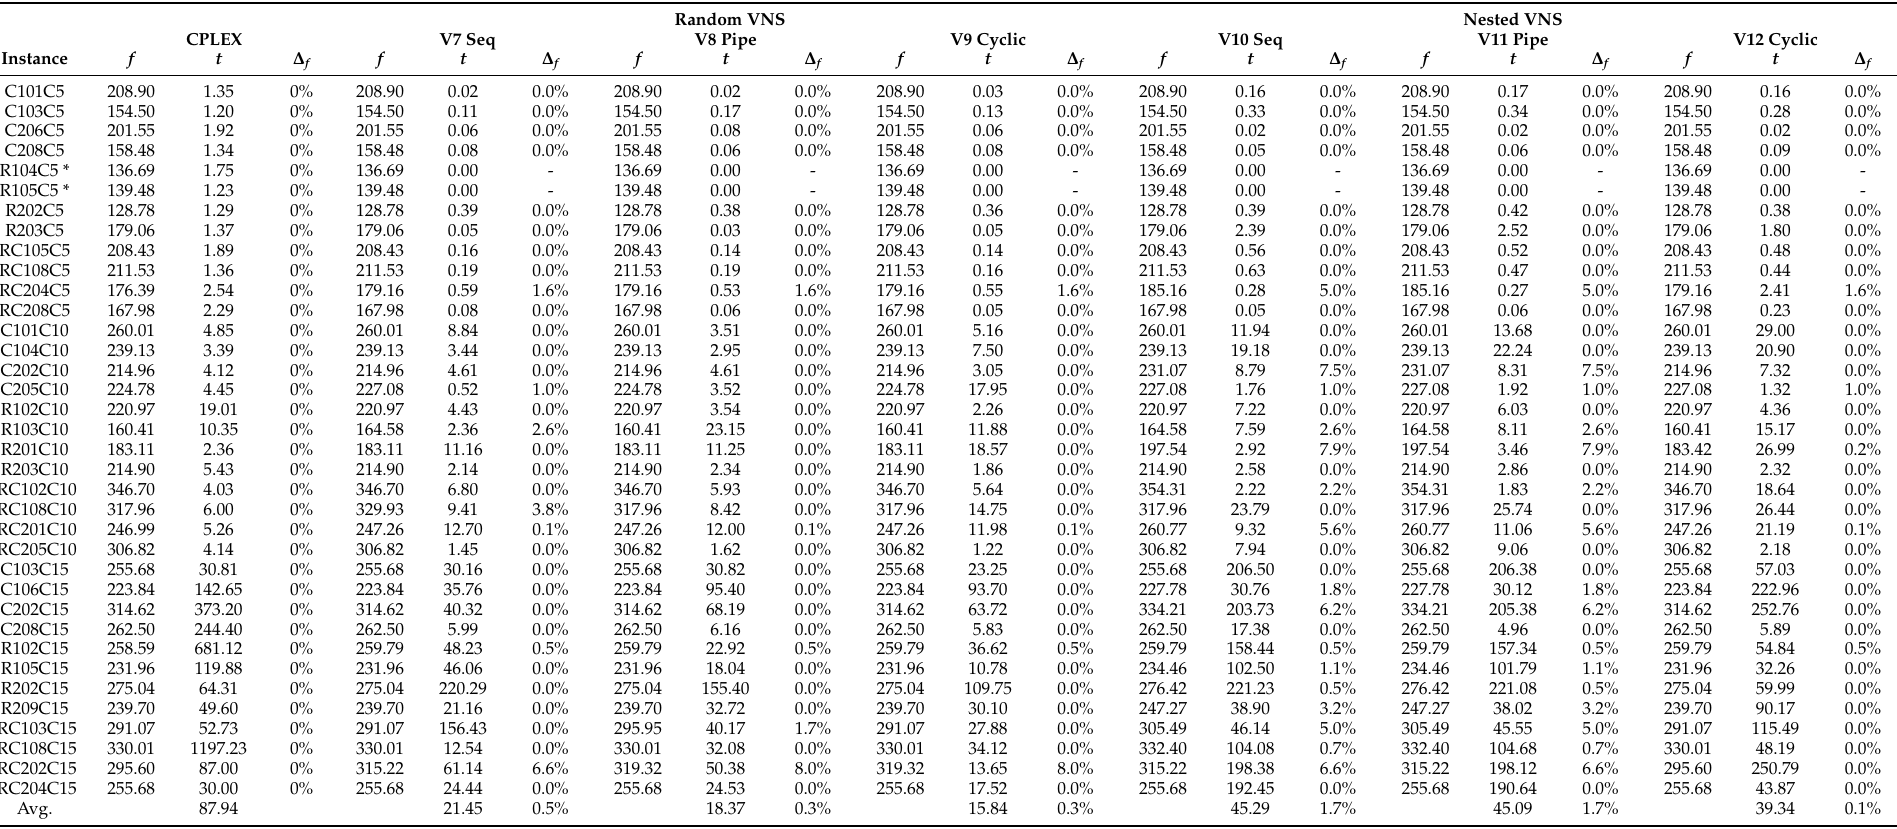
Table 6. Comparison of CPLEX vs. VNS variant results on small-sized